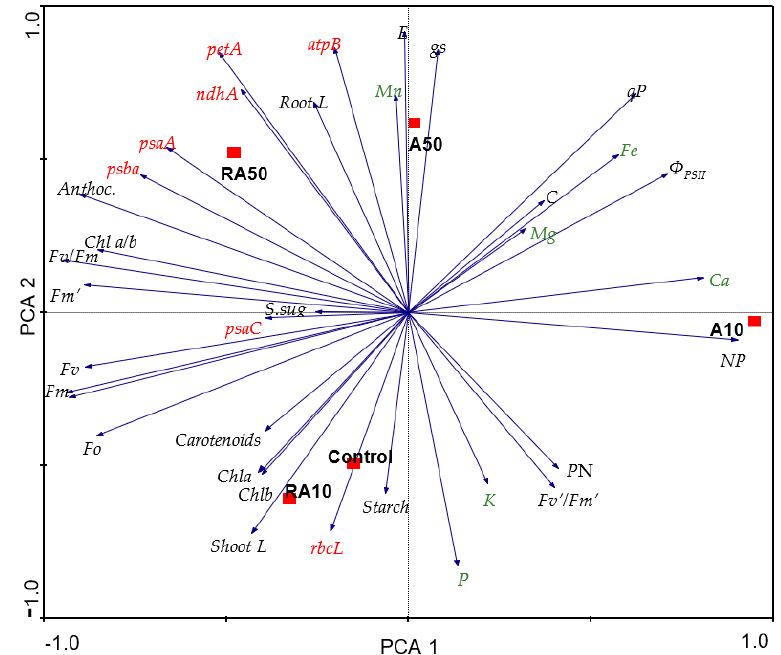
Figure 4. PCA biplot of A and RA treatment (10 mg ∙ L − 1 and 50 mg ∙ L − 1 ) effects on lettuce plants. Loading plot for the first axis, PCA 1, explained 34% of the variance, and the second axis, PCA 2, explained 41%.